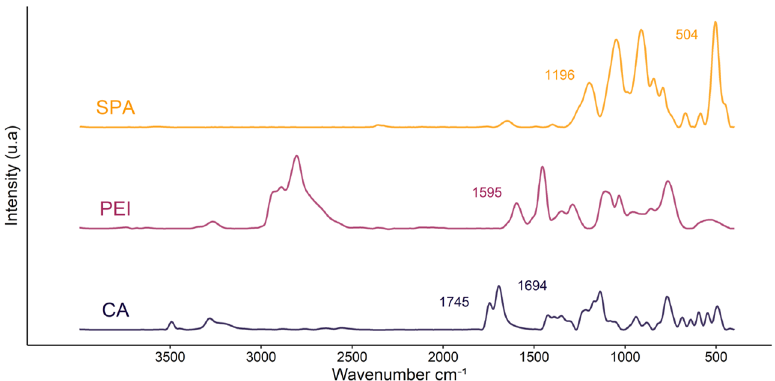
Figure 3. Spectra of sodium phytate (SPA), branched polyethyleneimine (PEI) andcitric acid (CA). Figure 4 compares the PEC made of PEI and SPA at a 1:1 ratio before and after acidification with CA. Before acidification, all characteristic peaks are shifted compared to the reference products. It is assumed that this shift resulted from the pH change from the original solution (PEI = 9, SPA = 3.4, PEI:SPA_1:1 = 9) and from the weak interaction between the two polyelectrolytes [53]. Acidification (PEI:SPA_1:1_AC = pH 5) led to further peak shifting and the appearance of new peaks around 1390 cm − 1 . Comparison of the pre- and post-acidification spectra confirms the change in interaction depending on the pH.